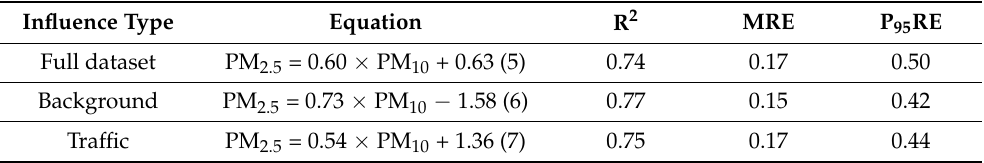
Table 2. Results of the different linear regressions on the full dataset, the background and traffic influence .